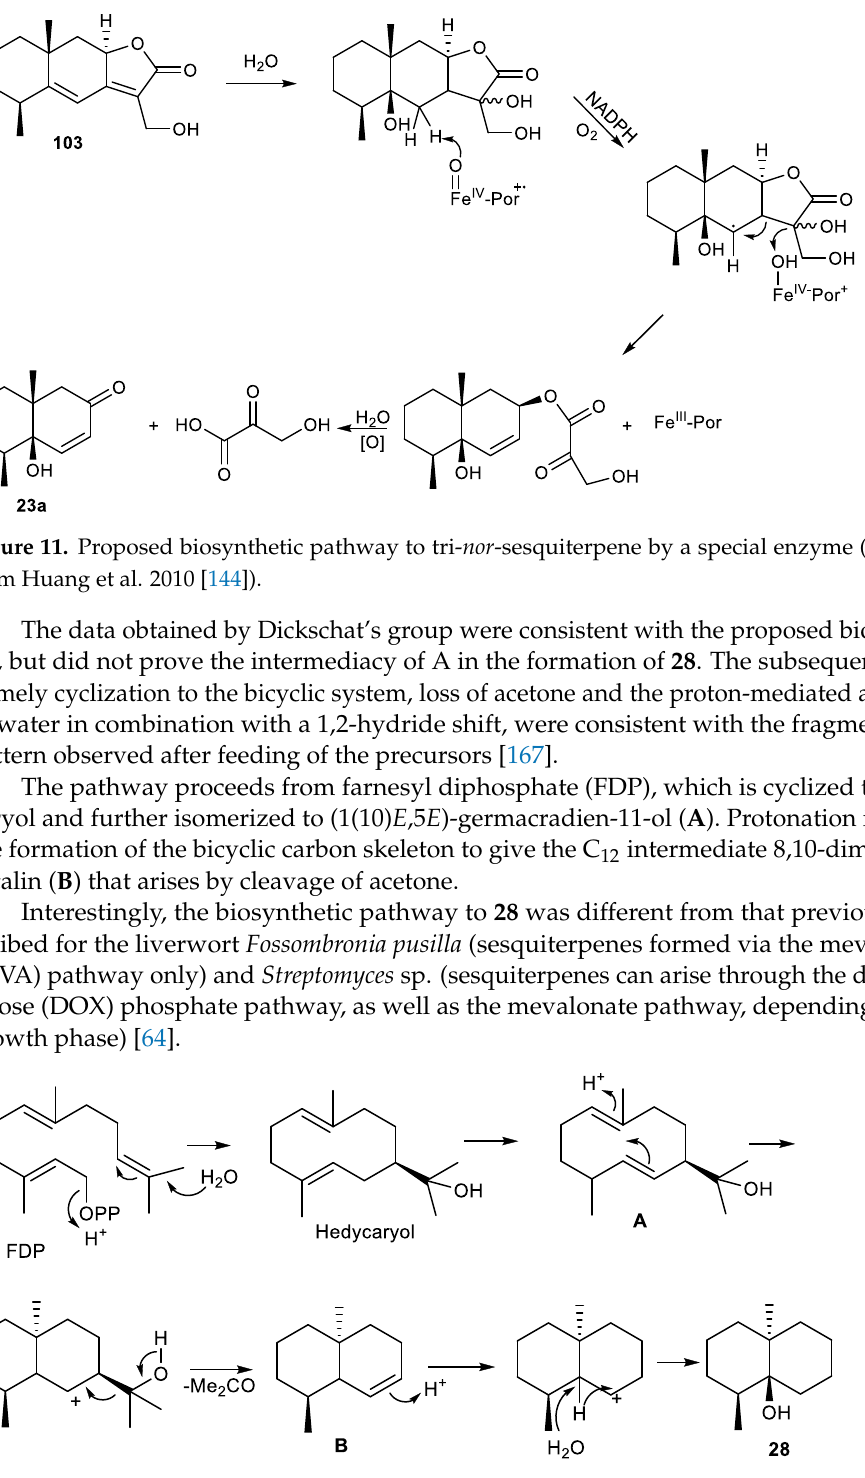
Figure 12. Biosynthesis of geosmin in M. xanthus and S. aurantiaca (adapted from Dickschat et al. 2005 [167])